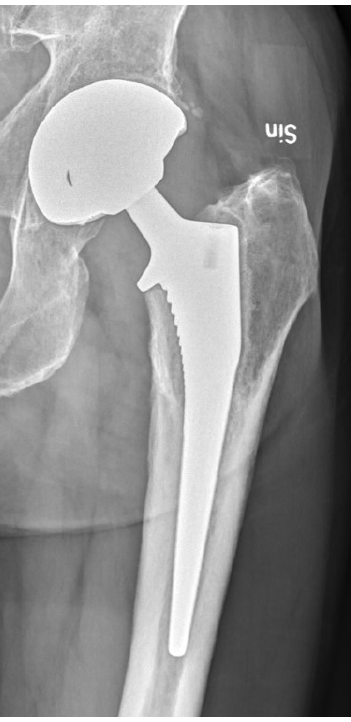
Figure 1. Radiograph of 4-year-old infection with coagulase nega- tive staphylococci (CoNS) in uncemented THAs. Radiolucent lines are evident around the cup in Charnley zone 3 and around the stem in Gruen zones 1 and 7. © 2021 Urban Hedlundh.